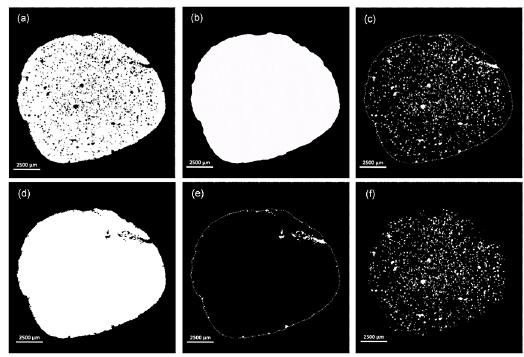
Open and closed pores can be rendered in 3D as shown in Figure 12, in which open and closed pores are shown in green and red, respectively.